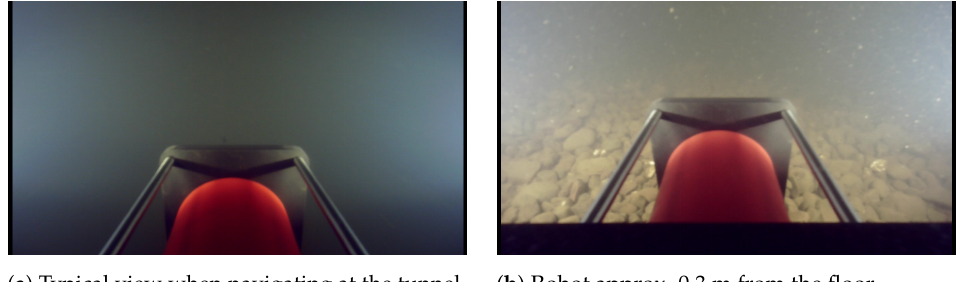
Figure 14. Low visibility using the low light camera at the tunnel: centered at the cross-section ( a ) and close the floor ( b